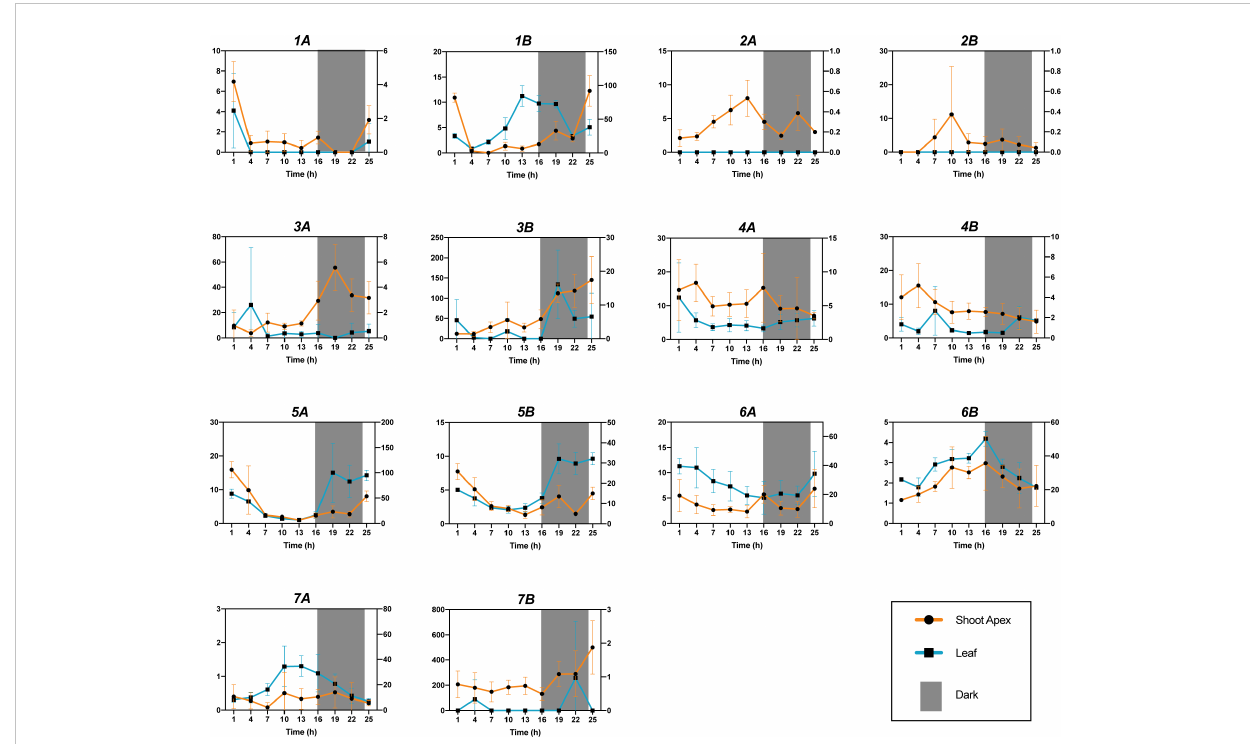
FIGURE 6 Diurnal expression of MdGA2ox genes in the shoot apex and fi rst fully expanded leaf in seedlings. The shoot apex and fi rst fully expanded leaf were excised from rapidly growing seedlings maintained under 16-h light/8-hr dark photoperiods. The y axis represents relative expression. Relative expression in the shoot apex and leaf is represented with orange and blue lines, respectively. The grey box in each graph indicates the period of